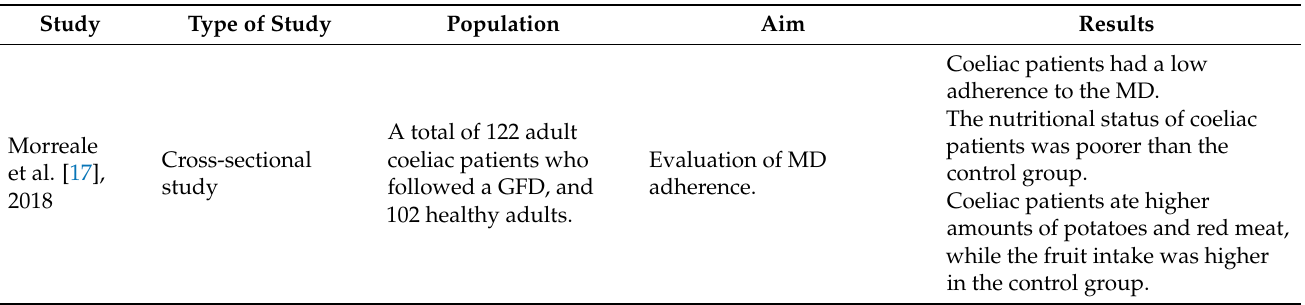
Table 3. Main characteristics of the studies regarding the use of the Mediterranean diet in Coeliac disease